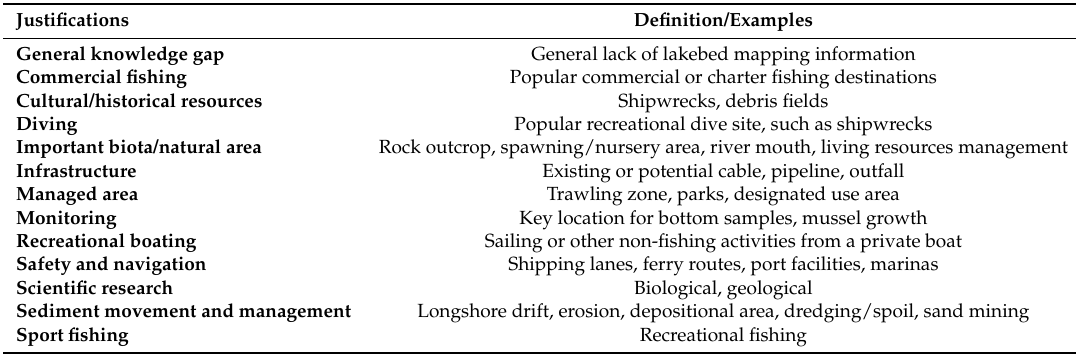
Table 2. Justifications listed in the pull-down menus to convey why an area should be